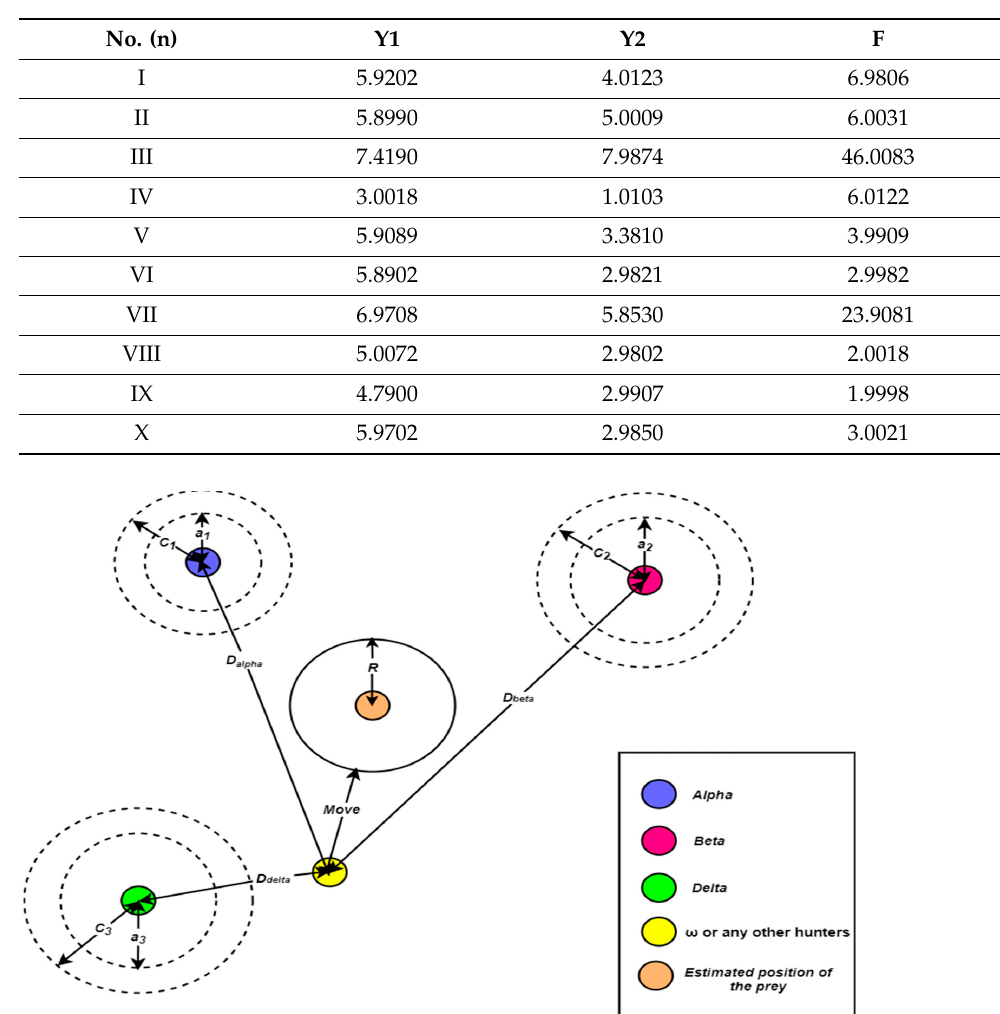
Table 3. Objective function values for random values of Y1 and Y2.